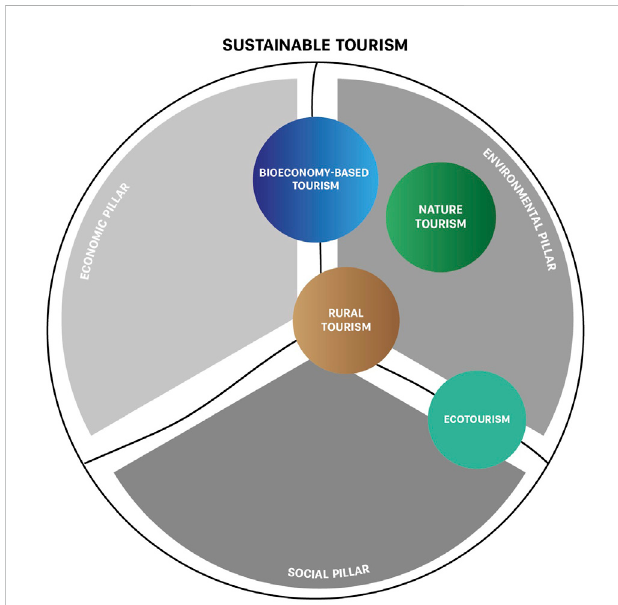
FIGURE 2 Graphic representation of the relationship between BE-based tourism and other forms of tourism from the point of view of sustainability pillars in de fi nitions of special tourism concepts (graphic processing by the